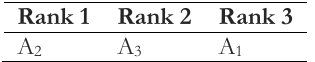
Table 15. Final LAM results for the case